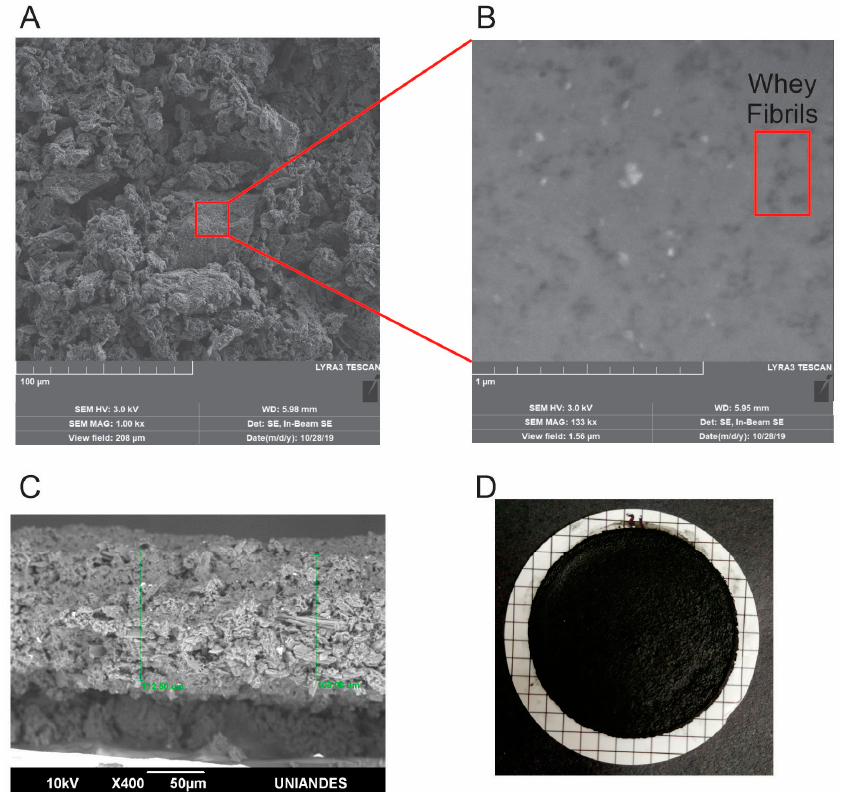
Figure 2. Morphological analysis of hybrid membrane of WPF and AC by SEM. ( A ) Image of the surface of the hybrid nanomembrane; ( B ) higher magnification (100 × ) of the SEM image of the hybrid membrane, showing in a circle the amyloid WPF adhered to the activated carbon; ( C ) SEM image of the transversal section of the membrane; ( D ) visual aspect of the membrane.